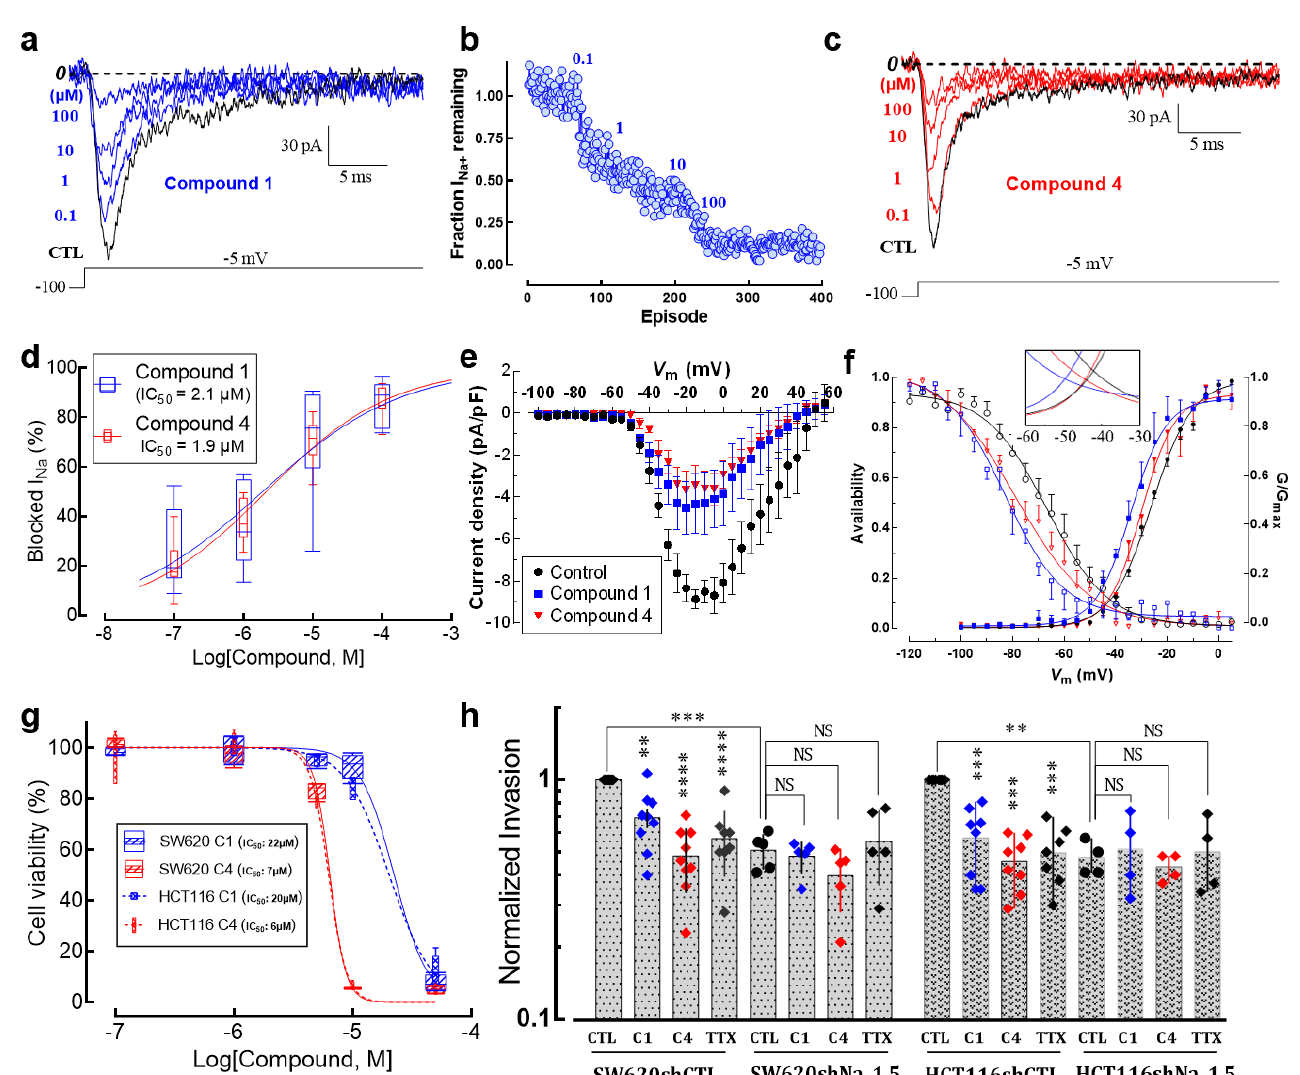
Figure 8. Small-molecule Na V 1.5 inhibitors reduce 2D colon cancer cell invasiveness. ( a ) Electrophysiological recordings showing the steady-state blockage of Na V 1.5 currents by increasing concentrations of compound 1 (from 0.1 to 100 µM). Whole-cell patch clamp experiments were carried out in SW620 cells. Voltage steps of 30 ms to −5 mV from an HP of −100 mV evoked Na + currents. The dotted line represents the zero current level. ( b ) Time course of inhibition of Na V 1.5 currents by compound 1 is shown. Peak currents were normalized to control amplitude (before compound 1 exposure), defined as the fraction of I Na+ remaining. Each blue circle means the amplitude at the peak current of an individual trace (episode) normalized to the control current amplitude. The solid line only connects the symbols. Then, the perfusion of the control solution was changed to a solution of the same ion composition plus the lowest concentration of compound 1 (0.1 µM). This solution was continuously perfused until a steady-state block was observed before proceeding to the next concentration and so on. The total duration of this experiment was 400 episodes, meaning around 13 min (1 episode every 2 s). Compounds 1 and 4 were poorly washed out, exhibiting a recovery of the original sodium current < 20%. ( c ) Representative recordings of the inhibitory effect of compound 4 on SW620 Na V 1.5 currents. ( d ) Concentration – response relationships for the effect of compound 1 and 4 on Na V 1.5 channels. Percentage of Na + current inhibition at each concentration was plotted and the experimental data fitted with a Hill function. Inset shows the IC 50 values obtained for each compound. ( e ) Current – voltage relationships of Na V 1.5 channels in the absence and presence of small-molecule compounds. Peak current amplitudes were normalized to the membrane capaci- tance ( C m ) value of each cell. ( f ) Activation (filled symbols) and steady-state inactivation – voltage